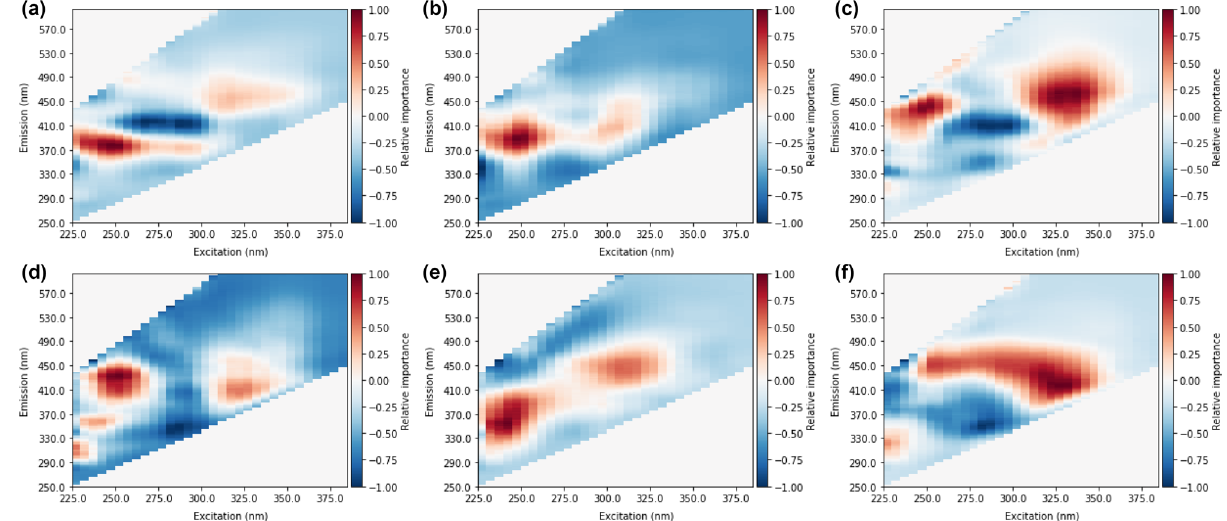
Figure 4. Heat maps from random occlusion of variable importance for CNN prediction of ( a ) total THMs, ( b ) trichloromethane, ( c ) bromodichloromethane, ( d ) total HAAs, ( e ) trichloroacetic acid, ( f ) dichloroacetic acid.